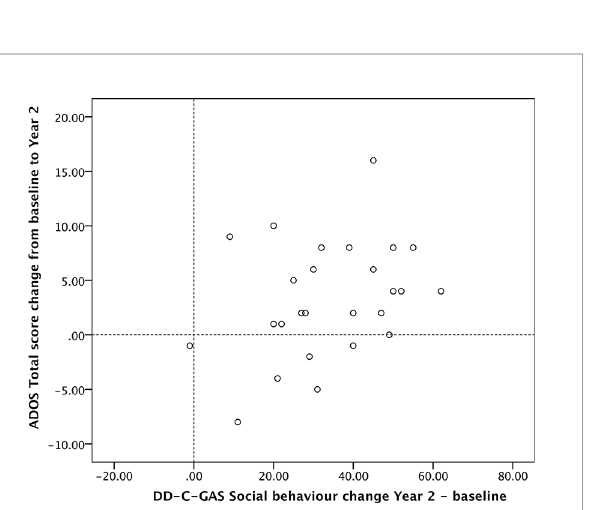
FIGURE 3 | Box plot: DD-C-GAS Social behavior (N = 25). Non-parametric repeated measures ANOVA (Friedman test): p = 0.000***. Pairwise comparisons between time points (Wilcoxon signed rank test): p-values adjusted by Bonferroni – Holm were 0.000***, except for comparison Day 18 to Year 1 (p = 0.002**), Year 1 to Year 2 (p = 0.145).